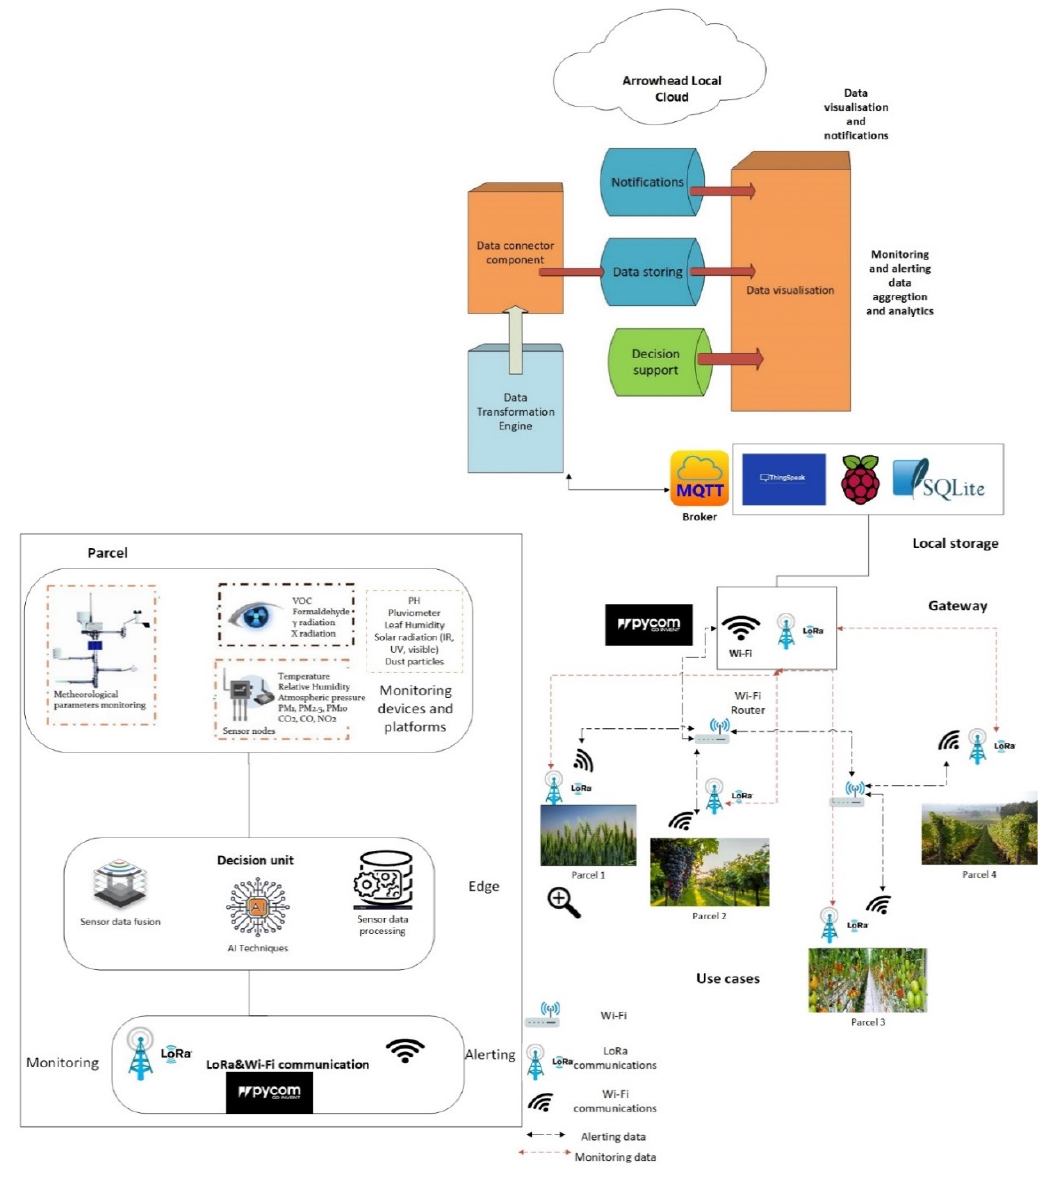
Figure 24. SmartAgro innovative architecture.